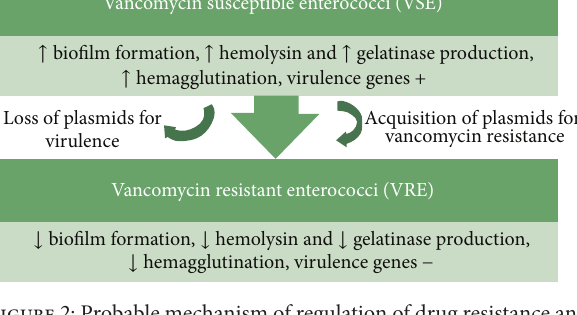
Figure 2: Probable mechanism of regulation of drug resistance and virulence in